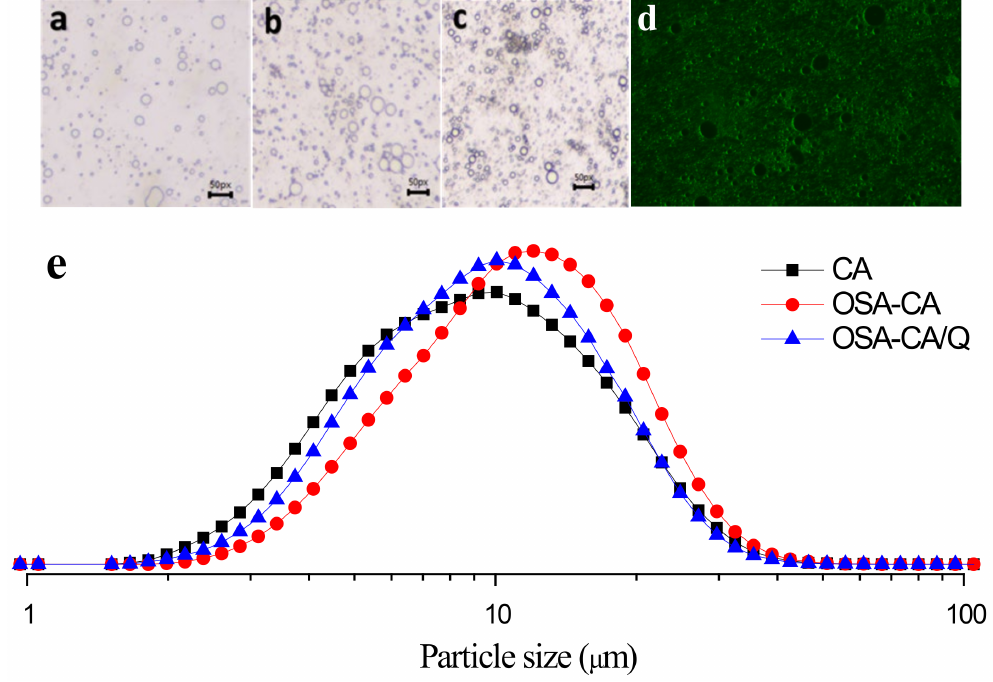
Figure 4. Micromorphology of emulsions. Scale bar = 50 µ m. ( a ) PE; ( b ) SE; ( c ) TE and ( d ) fluorescence microscopy of emulsion and ( e ) effects of different emulsifiers on droplet